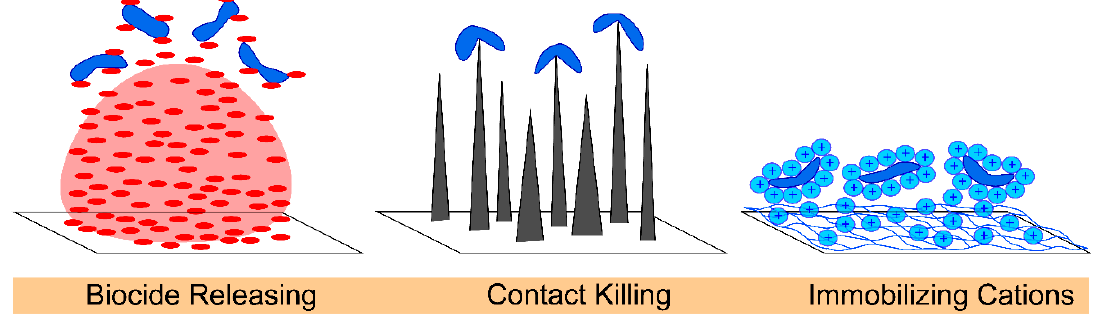
Figure 2. Antibacterial surfaces inactivate microorganisms by either releasing biocides, having